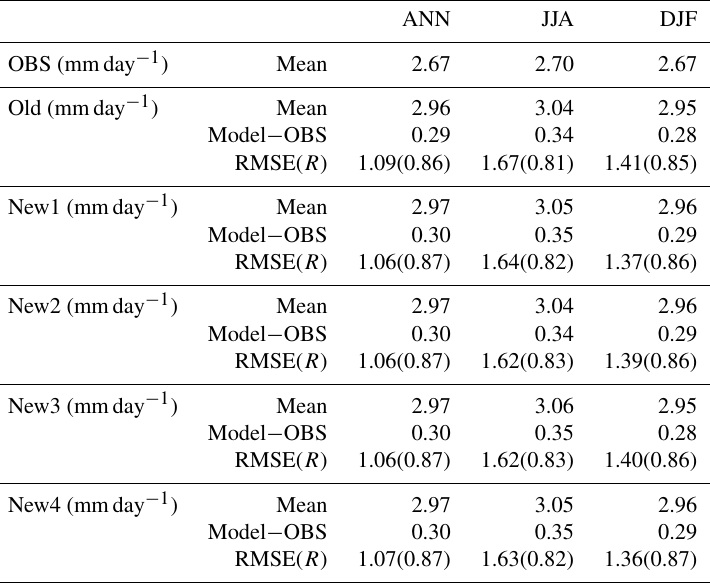
Table 5. Mean (annual and seasonal global mean values) and Model–OBS (the difference of annual and seasonal global mean values between models and observations), RMSE (root mean squared error), and R (spatial pattern correlation) of the modeling results compared to the observed precipitation rate from GPCP for ANN, JJA, and DJF.